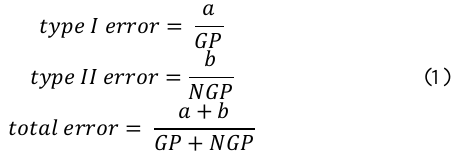
where, 𝑎 is the number of ground points classified as non- ground (omission error) and 𝑏 is the number of non-ground points classified as ground (commission error). 𝐺𝑃 and 𝑁𝐺𝑃 stand for the total number of ground and non-ground points, respectively (Montealegre et al.,